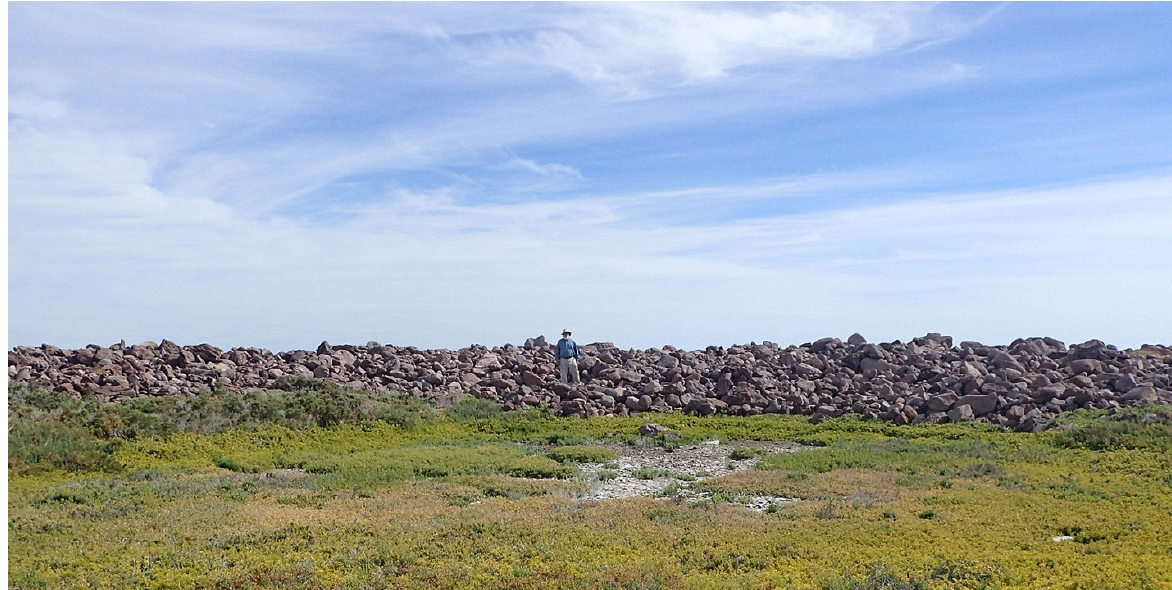
Figure 8. Inner side of an unconsolidated Holocene deposit at Ensenada Almeja formed by rhyolite boulders eroded from an adjacent sea cliff (out of view to the right) stacked to a height of 2 m [24].